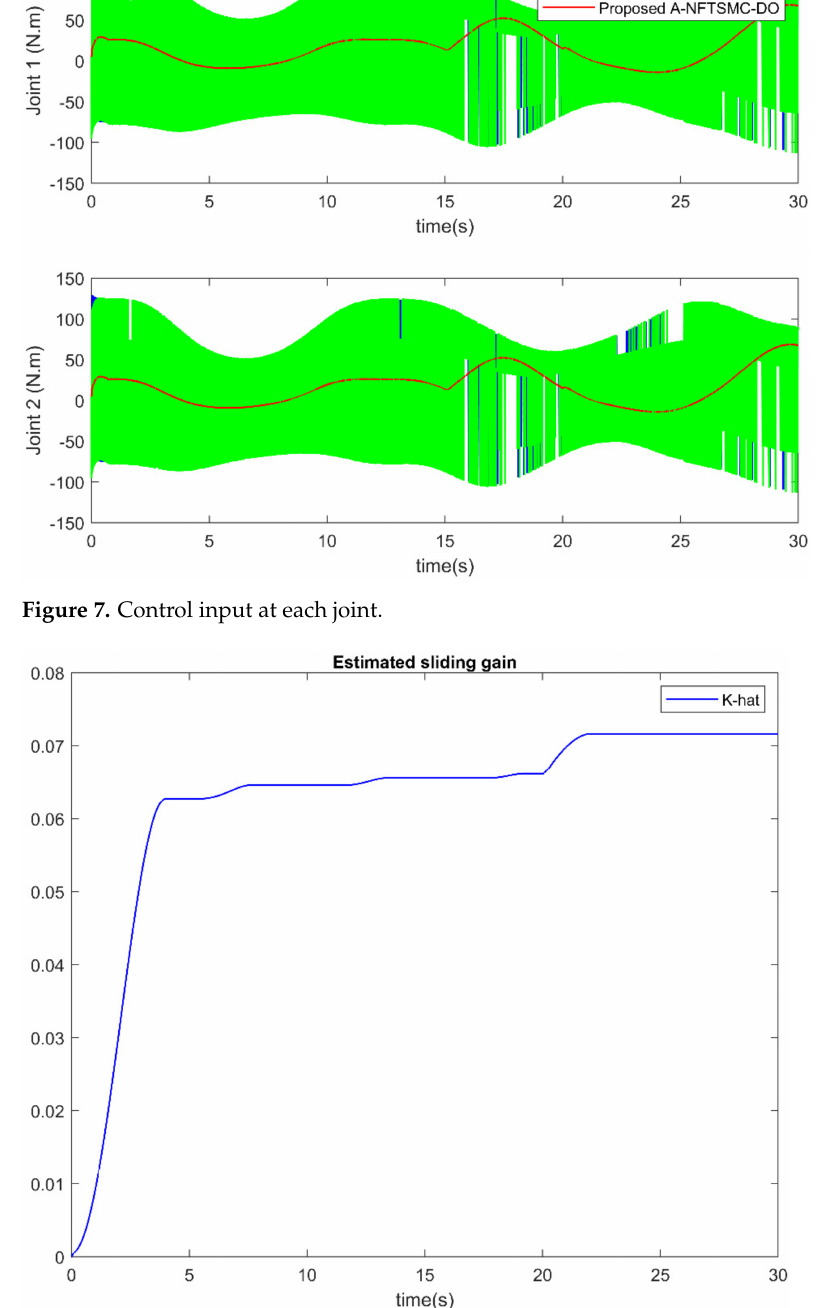
Figure 8. Estimation of sliding